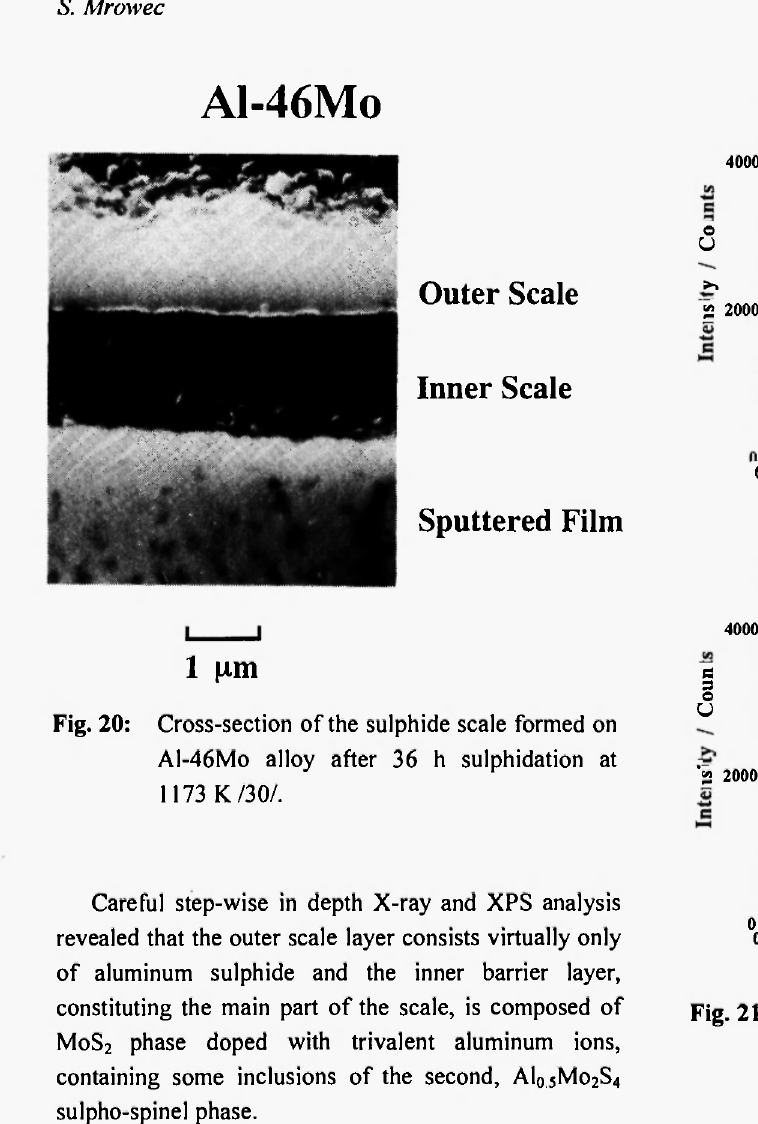
Fig. 21: RBS spectra for gold-marked Al-46Mo alloy specimen before and after its sulphidation at 1073